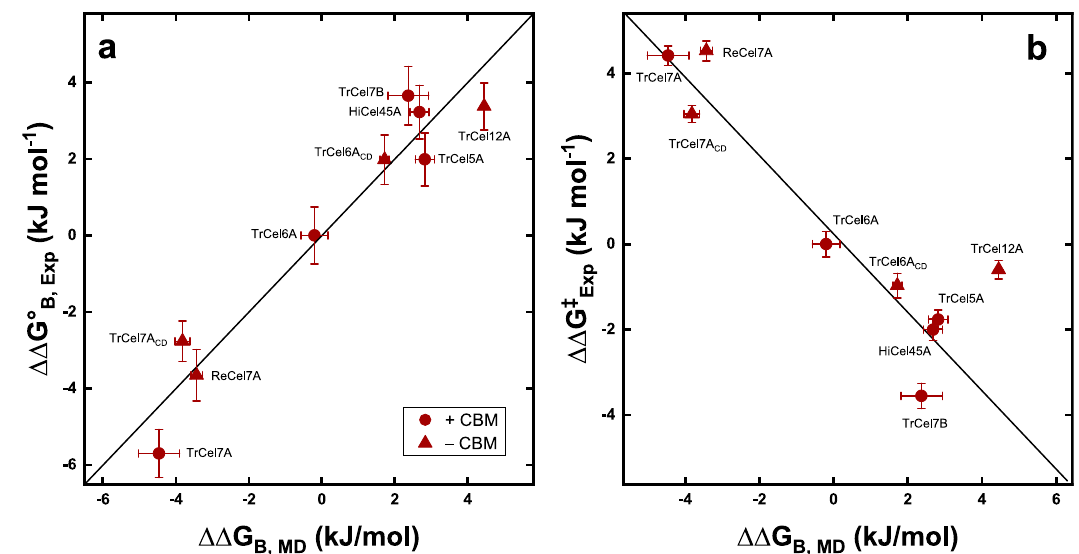
Fig. 3 Correlation of computed and experimental free energies for nine selected cellulases. a Changes in computed free energies of binding ( ΔΔ G B,MD ) and experimental changes in binding free energy ( ΔΔ G B,exp ). b Correlation of ΔΔ G B,MD and experimental changes in activiation free energy ( ΔΔ G ‡ exp ). Experimental free energies were calculated using Eqs. 2 and 3. The kinetic parameters (K M and k cat ) of the nine cellulases can be found in supplementary Table 4. The selected cellulases covered a wide range of kinetic parameters shown in Fig. 2 and encompassed all main structural and functional traits speci fi ed in Fig. 1. Standard deviations of the experimental free energies and computed free energies are shown as error